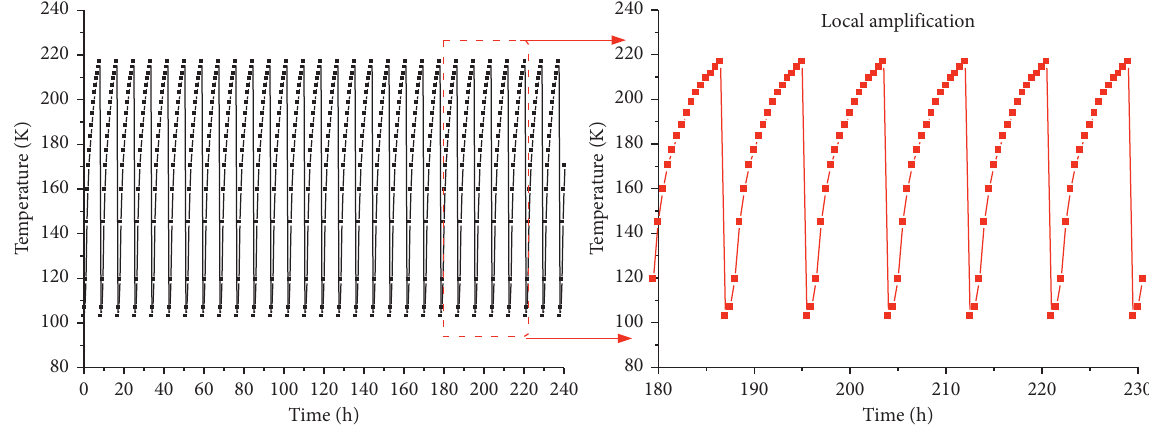
Figure 6: Periodic temperature variation in the freezing hole.